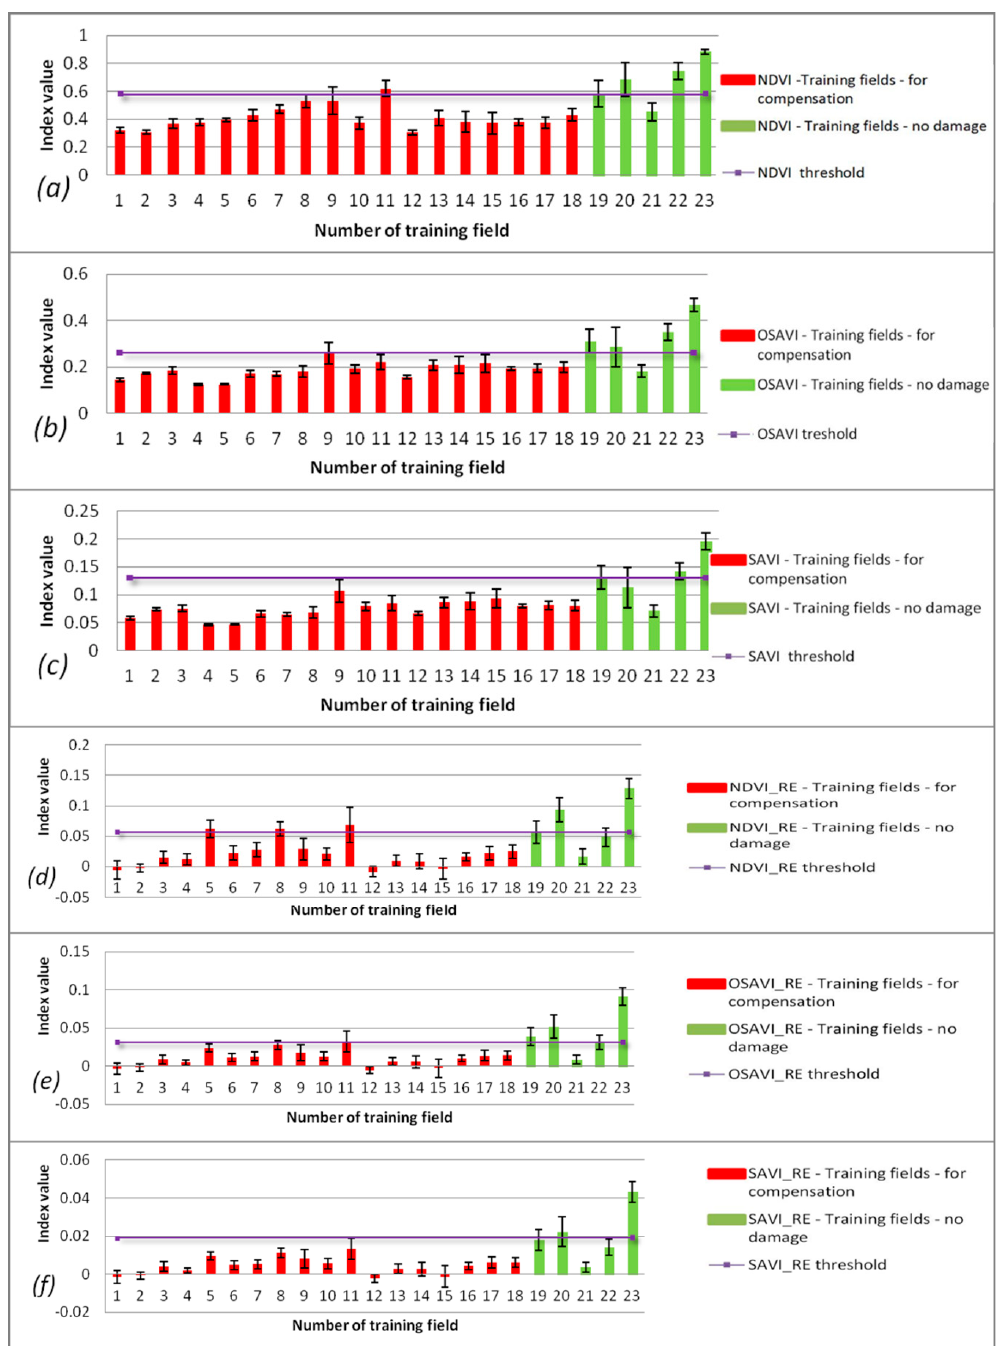
Figure 4. Interpretation of training fields with selected thresholds according to indices: Normalized Difference Vegetation Index (NDVI) ( a ), Optimized Soil Adjusted Vegetation Index (OSAVI) ( b ), Soil Adjusted Vegetation Index (SAVI) ( c ), Normalized Difference Vegetation Index—Red Edge (NDVI_RE) ( d ), Optimized Soil Adjusted Vegetation Index—Red Edge (OSAVI_RE) ( e ), and Soil Adjusted Vegetation Index—Red Edge (SAVI_RE) ( f ). The training fields are ranked according to the condition of plants. The chart shows the average value of index for each of the training fields with the standard deviation.